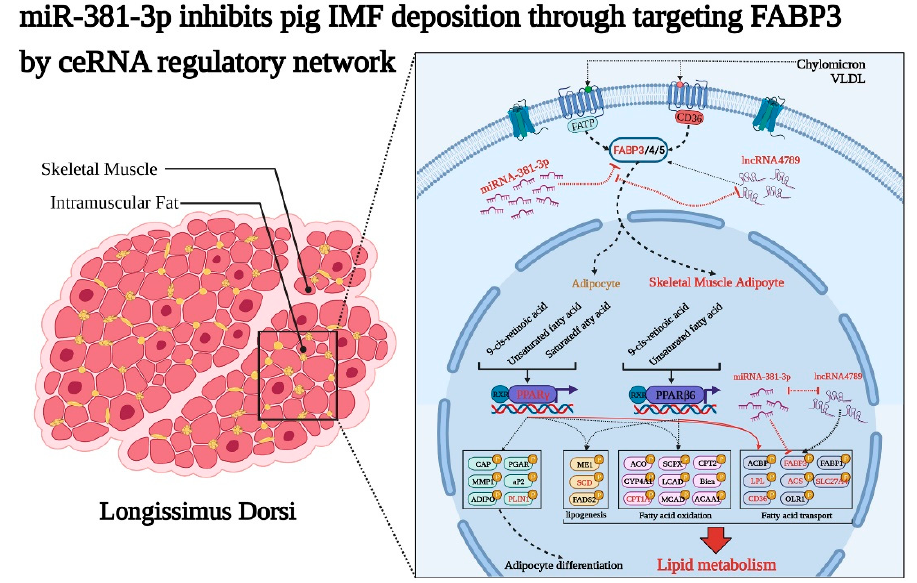
Figure 7. MiR-381-3p inhibits IMF deposition through targeting FABP3 , while lncRNA4789 relieves the inhibitory effects of miR-381-3p on FABP3 in pig longissimus dorsi via a ceRNA regulatory net- work.